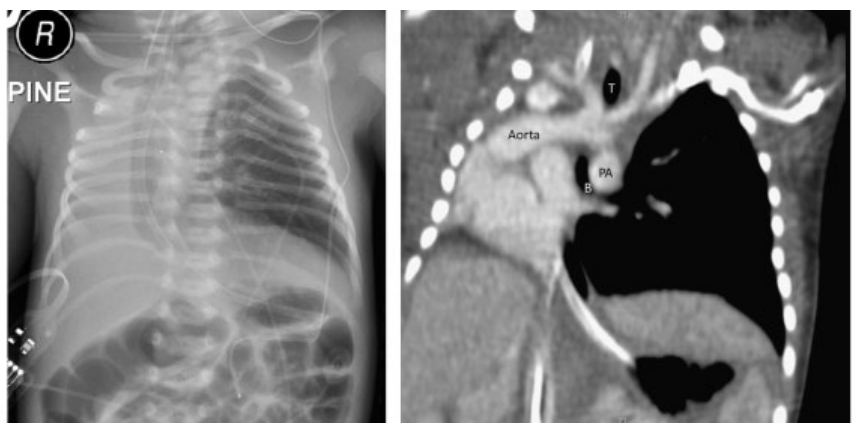
Fig. 1 Postnatal chest radiograph (A) showing right pulmonary agenesis, and mediastinal shift toward the right. Frontal reconstruction of the chest computed tomography shows the airway (T-trachea, B-bronchus) coursing around the pulmonary artery (PA) into the emphysematous unilateral left lung (B).